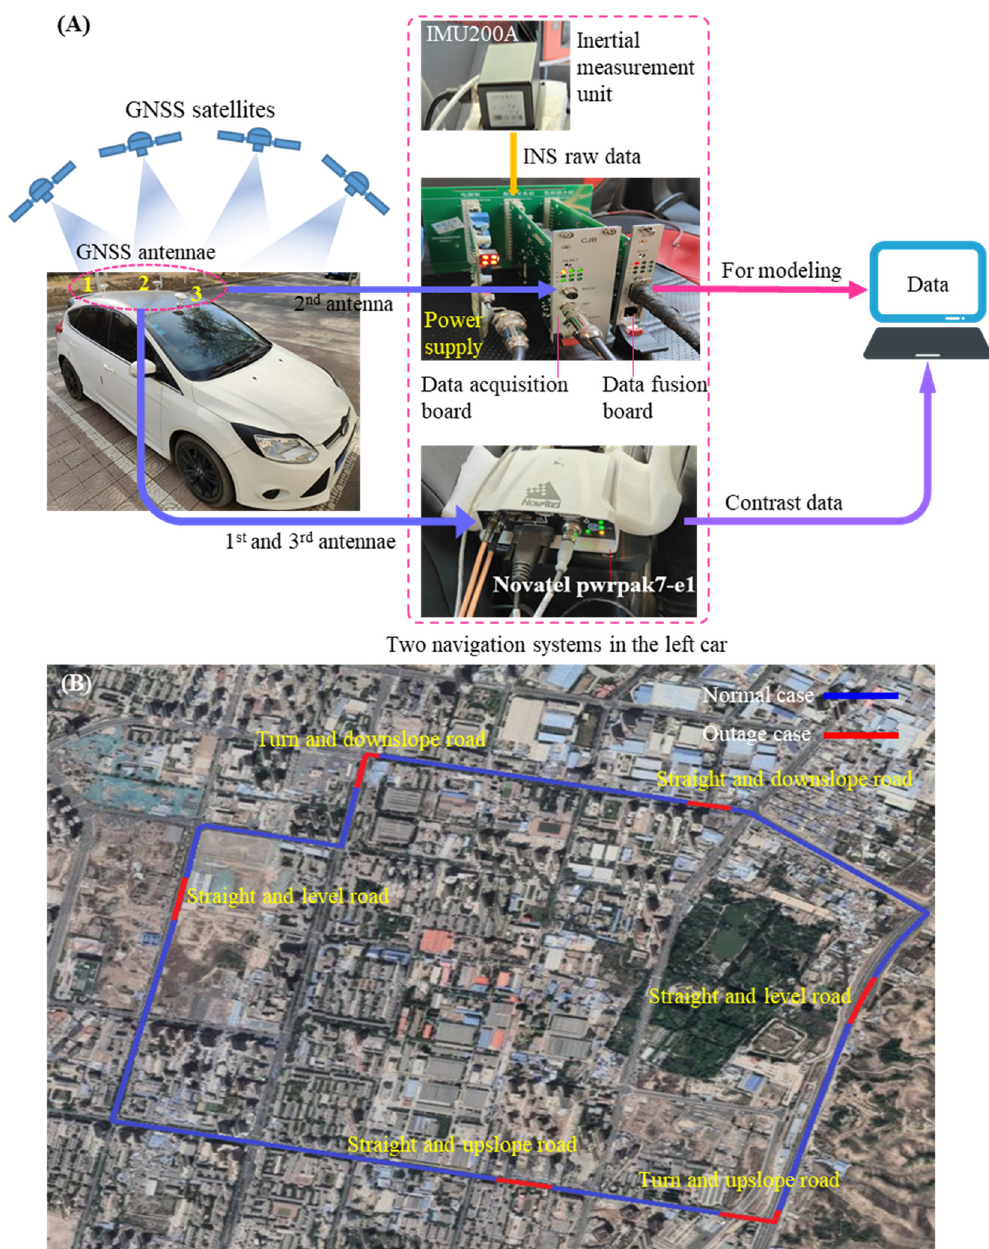
Figure 2. Experimental device and method. ( A ) Two integrated navigation systems, 1—1st anten- nae; 2—2nd antennae; 3—3rd antennae; ( B ) closed-loop experimental road trajectory. 2—2nd antennae; 3—3rd antennae; ( B ) closed-loop experimental road